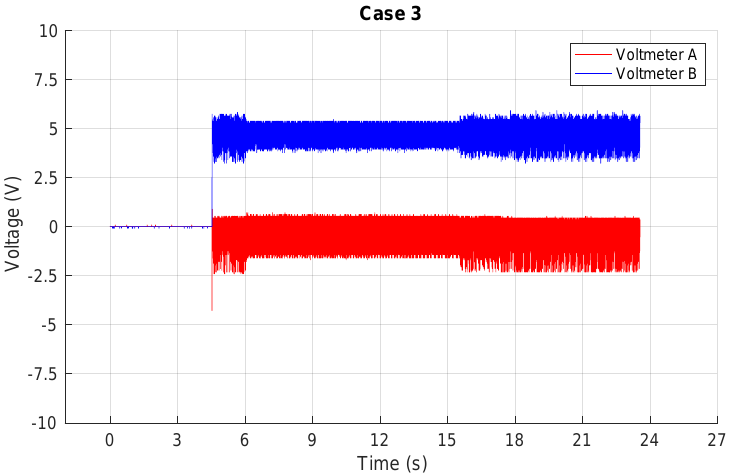
Figure 13. Case 3: Experimental results. During approximately 9 s, the aluminum container was filled with cat litter, as the voltmeter diagrams